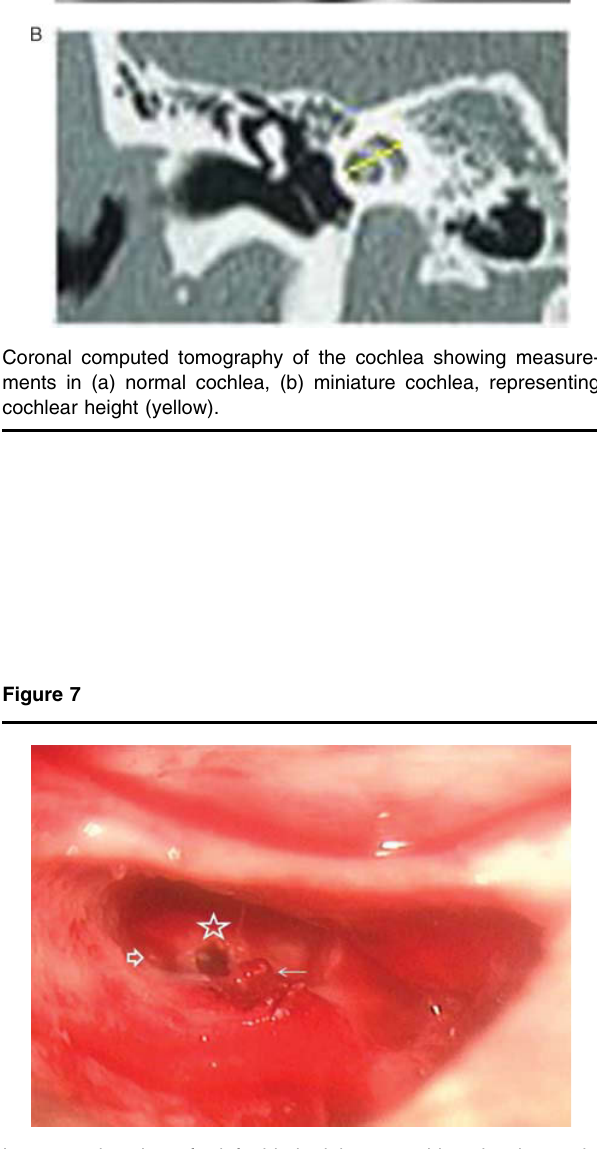
Intraoperative view of a left-sided miniature cochlea showing coch- leostomy (fx1), round window niche (fx2), and stapes head ( ← ).